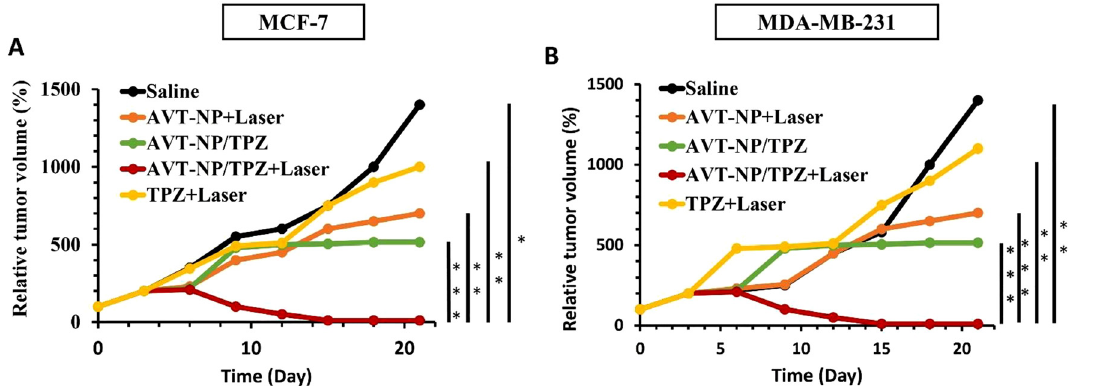
Figure 36: MCF-7 tumor (A) and MDA-MB-231 (B) growth curves after intravenous injection of different drug formulations (0.1 mg/kg; Ps/body